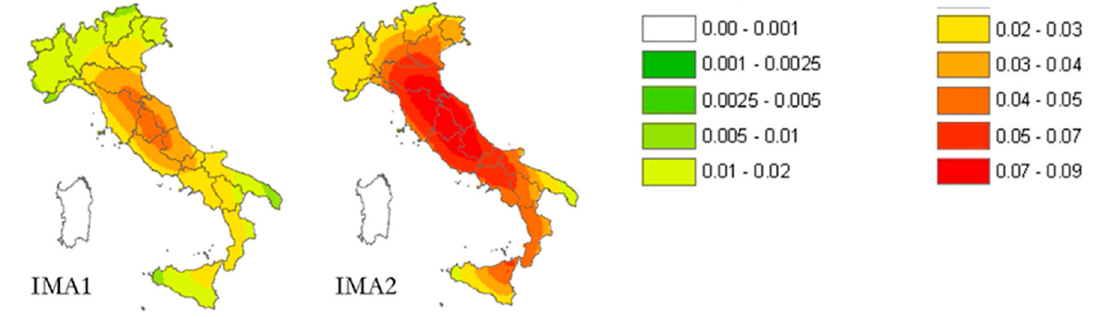
Figure 3. Italian risk maps of the annual damage factor for masonry buildings with (IMA1) and without (IMA2) tie rods and/or tie beams [23].